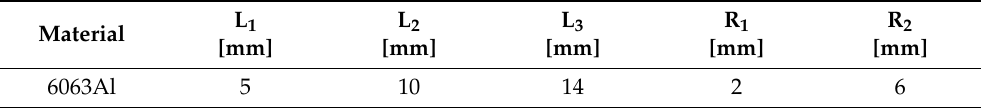
Table 2. Dimension parameters of a 6063-aluminum dog-bone-shaped alloy sample. Material